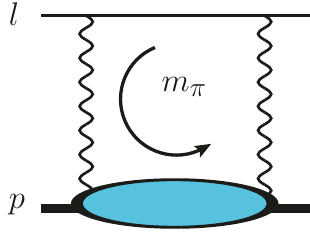
Figure 1 . Symbolic representation of c pl 4 , TPE . The bubble represents the forward virtual-photon Compton tensor. It includes scales of the order of the lepton mass and higher (including the pion